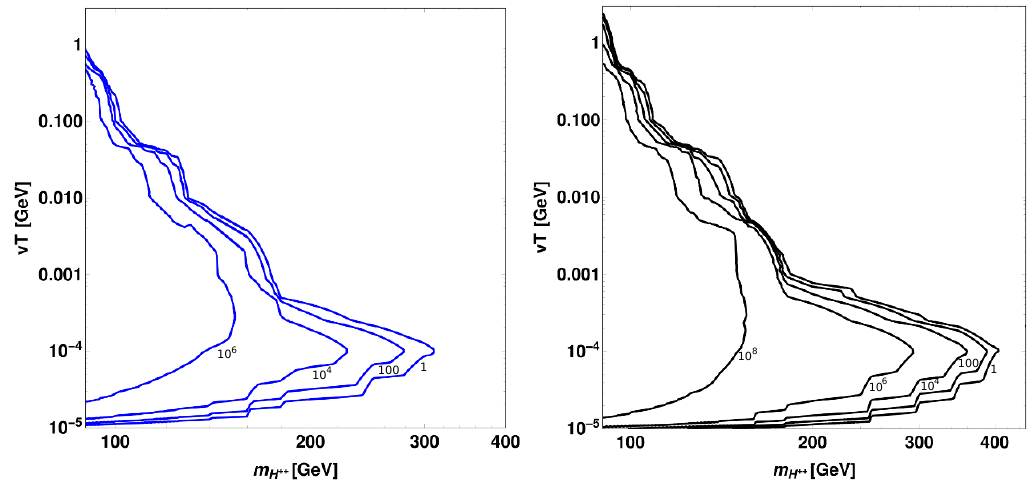
Figure 6 . Total number of doubly charged Higgs bosons decaying with a displacement between the boundaries x 1 = 1 mm and x 2 = 1 m, for the HL-LHC (left) and the FCC-hh (right). For this (cid:12)gure we consider the production channel pp